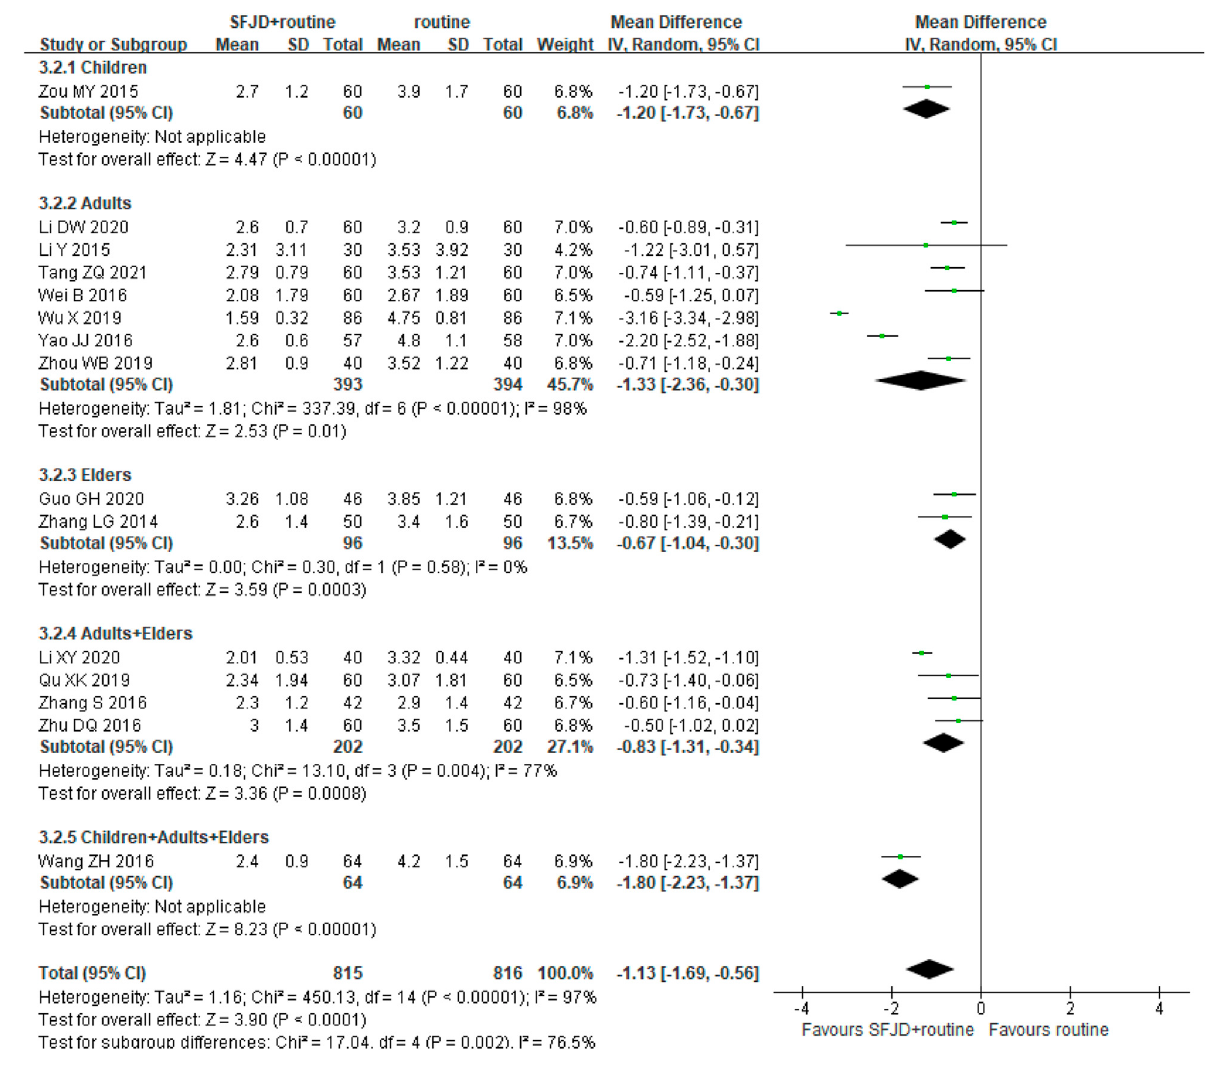
Frontiers in Pharmacology |